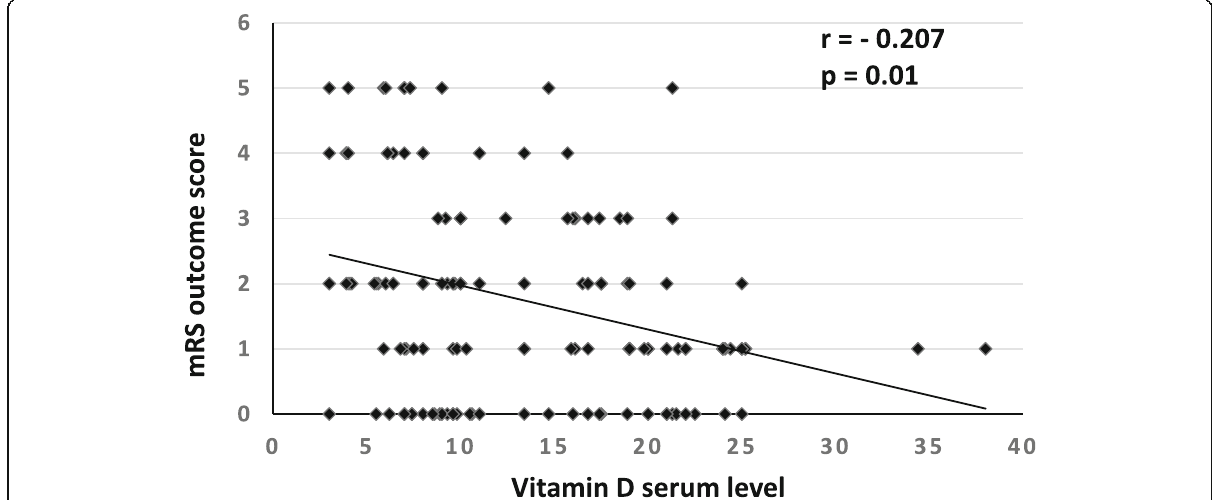
Fig. 2 Partial correlation analysis after controlling for NIHSS score and infarction size shows that vitamin D serum level (ng/ml) demonstrated significant negative correlation with mRS stroke outcome score